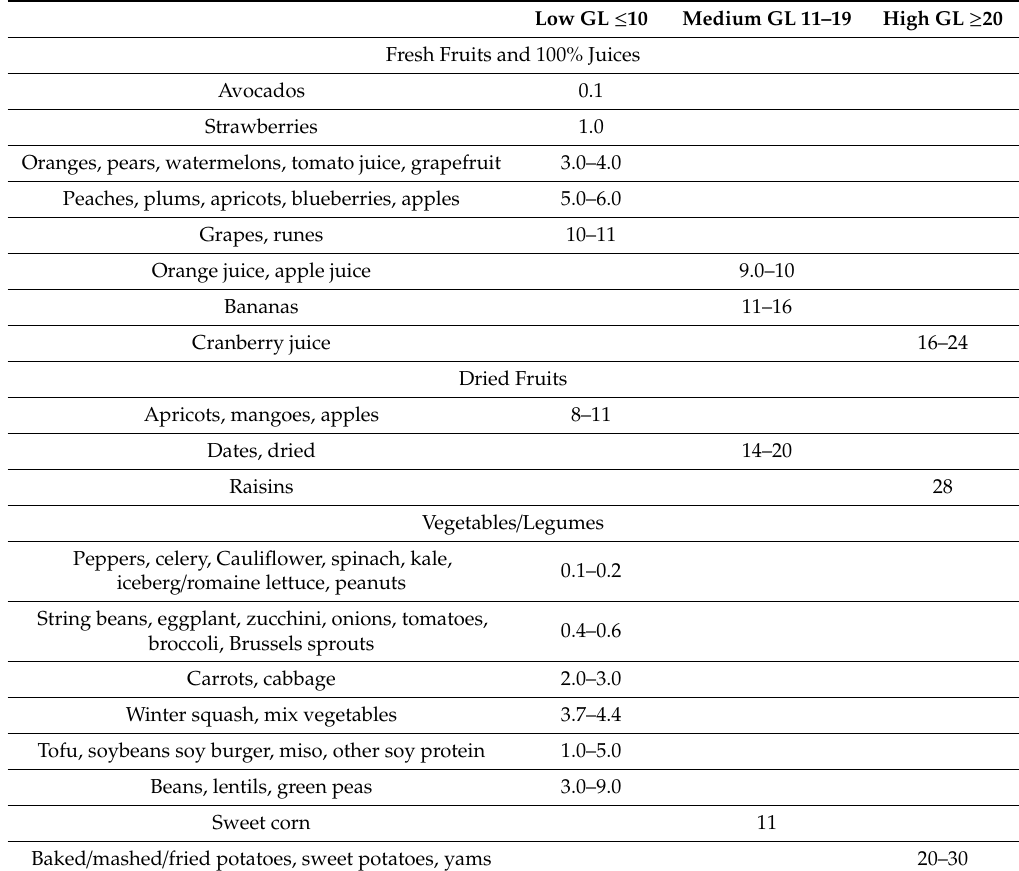
Figure A1. Multivariate adjusted association between dietary pattern adherence and change in body weight from the 51,670 Nurses’ Health Study II women (mean baseline age 26 to 46 years and BMI of 24) over 9-year follow-up [14]. Table A1. Estimated glycemic load (GL) for fruits and vegetables/legumes per serving [18,85].